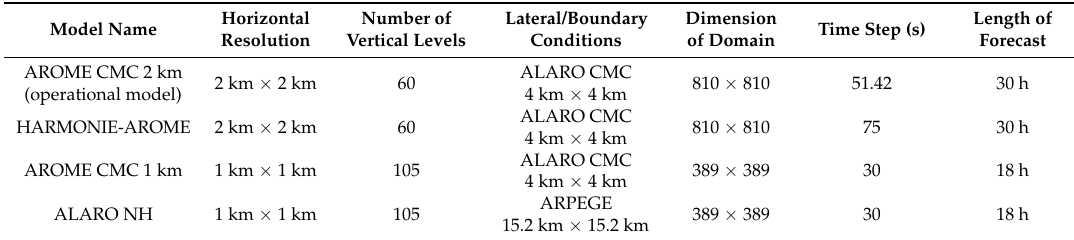
Table 2. Configurations of models used in the study. AROME, Application of Research to Operations at Mesoscale; CMC, canonical model configuration; HARMONIE, Limit é e Adaptation Dynamique D é veloppement International (ALADIN) High-Resolution Limited Area Model (HIRLAM) Regional/Mesoscale Operational Numerical Weather Prediction (NWP) in Europe AROME; ALARO NH, ALADIN-AROME